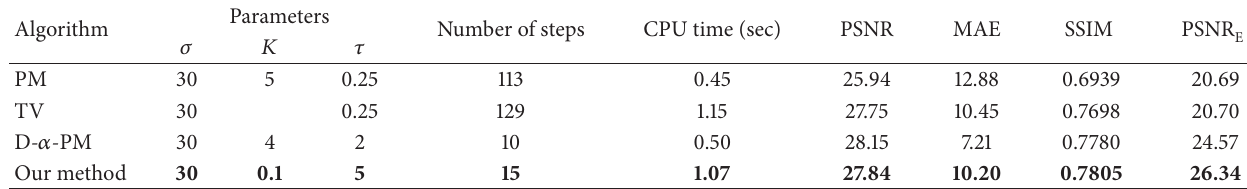
Table 2: Numerical results for Lena image (300 × 300)